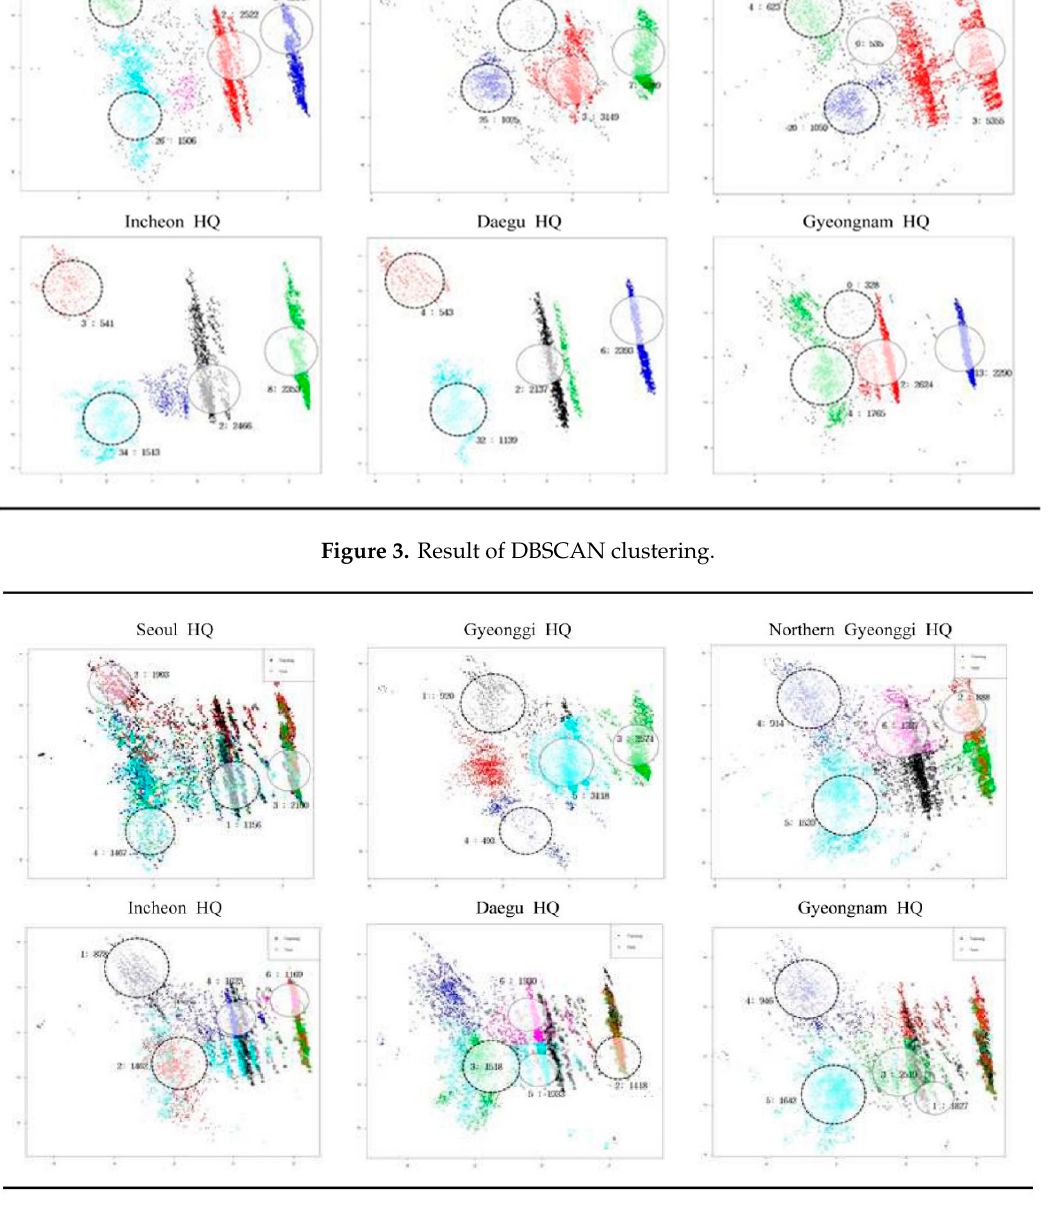
Figure 4. Result of K-means clustering.